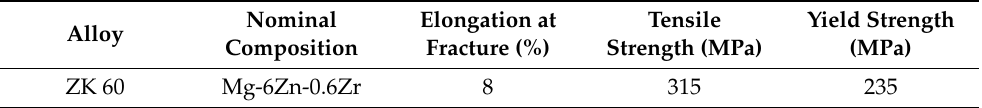
Table 1. Mechanical properties of ZK 60 [27]. Alloy